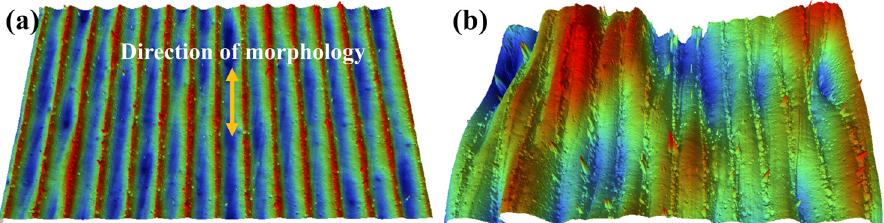
Figure 9. Surface morphology with di ff erent values of S tr . ( a ) S tr is approximately 0; ( b ) S tr is approximately 1.0.